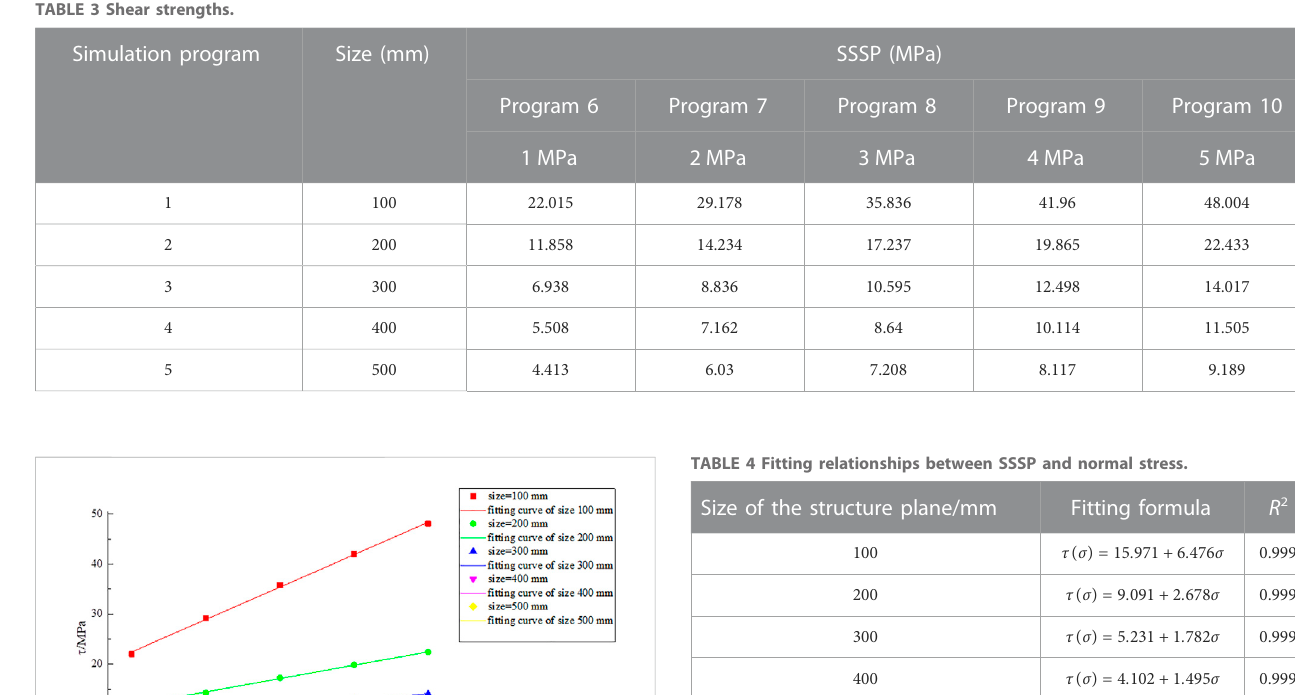
TABLE 3 Shear strengths.